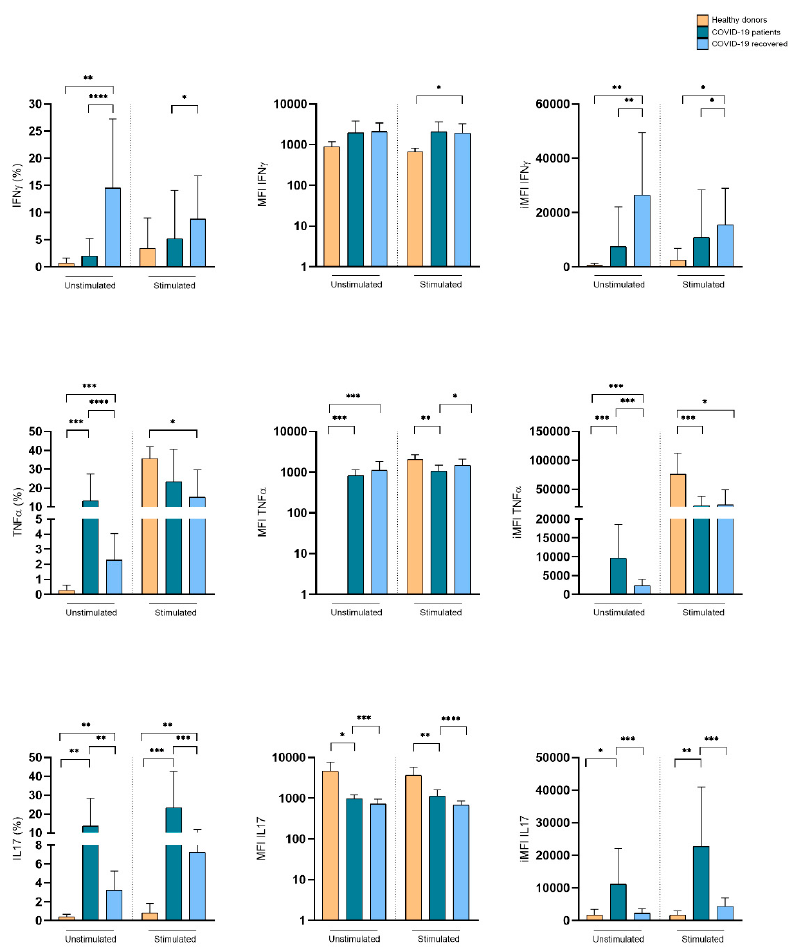
Figure 4. Expression of pro-inflammatory cytokines by V δ 1+ T lymphocytes in hospitalized and recovered COVID-19 patients, compared to healthy subjects. Cumulative histograms representing the expression of pro-inflammatory cytokines by V δ 1+ T lymphocyte. Shown are percentage ( left panels ), MFI ( central panel , log 10 scale), and iMFI ( right panels ) ± SD. * p < 0.05, ** p < 0.01, *** p < 0.001, and **** p < 0.0001.